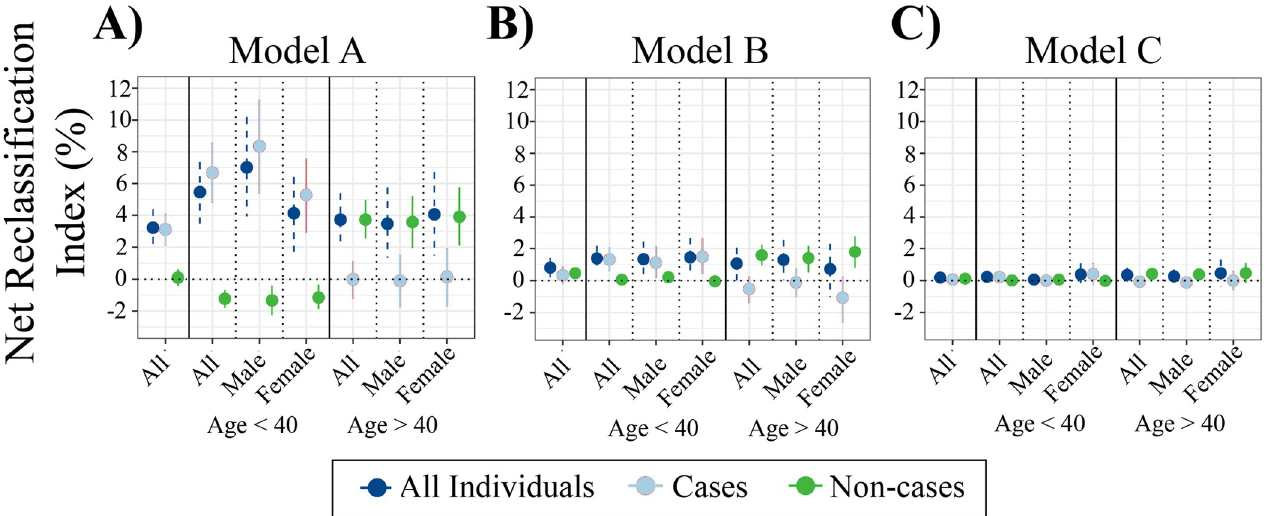
Fig 2. Performance of the IRT using NRI. NRI and 95% CIs comparing 10-year prediction of T2D between QDiabetes models A ( n = 13,648), B ( n = 4,334), and C ( n = 864) and IRTs combining each QDiabetes model with T2D PRS. NRI is presented overall and for age-by-sex subgroups. The NRI for individuals who subsequently develop T2D (cases) and who do not develop T2D (non-cases) are presented alongside the NRI for cases and non-cases combined (all individuals). CI AU : AbbreviationlistshavebeencompiledforthoseusedinFigs 2 (cid:0) 5 : Pleaseverifythatallentriesarecorrect : , confidence interval; IRT, integrated risk tool; NRI, net reclassification index; PRS, polygenic risk score; T2D, type 2 diabetes.